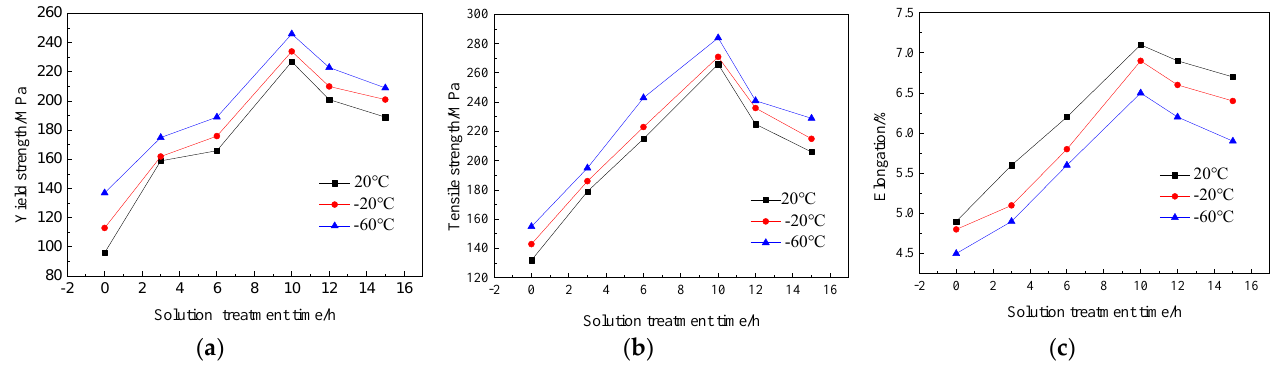
Figure 2. Low-temperature tensile properties of Al-7.0Si-0.3Mg alloy after different solution treat- ments: ( a ) yield strength, ( b ) tensile strength, ( c ) and elongation.